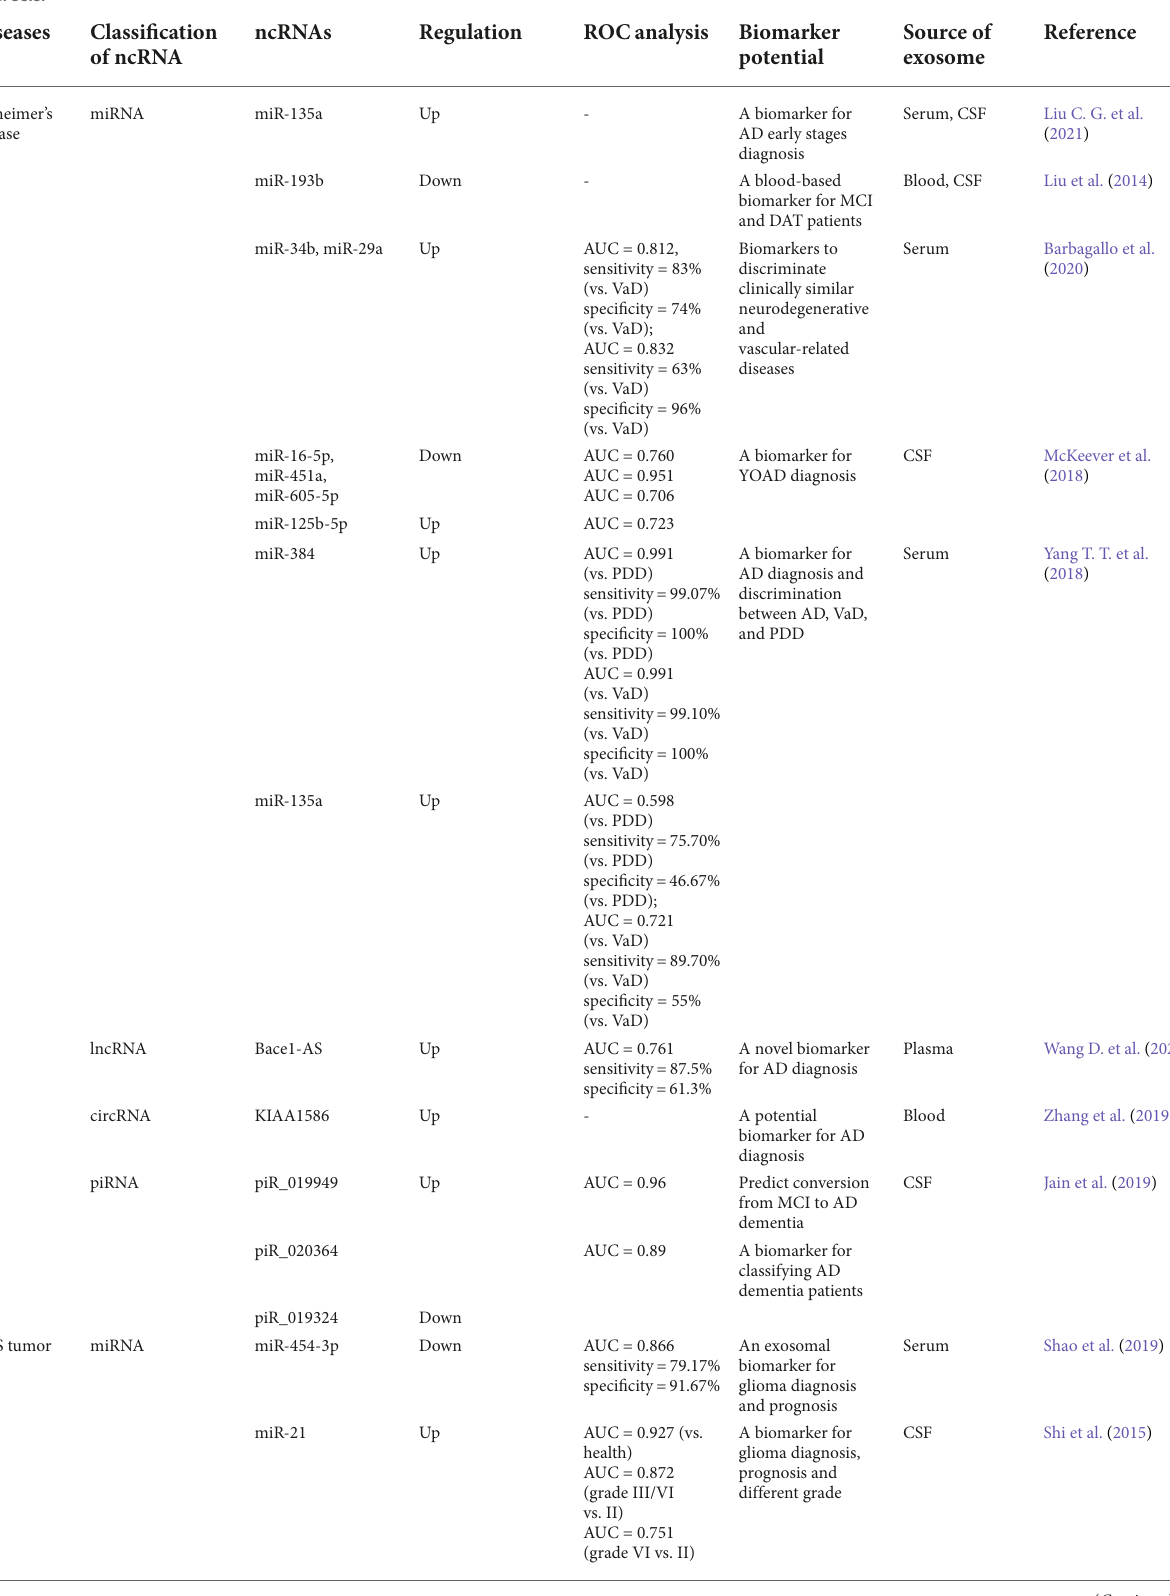
TABLE 4 The biomarker potential of exosomal ncRNAs in Alzheimer’s diseases, CNS tumors, multiple sclerosis, epilepsy, and amyotrophic lateral